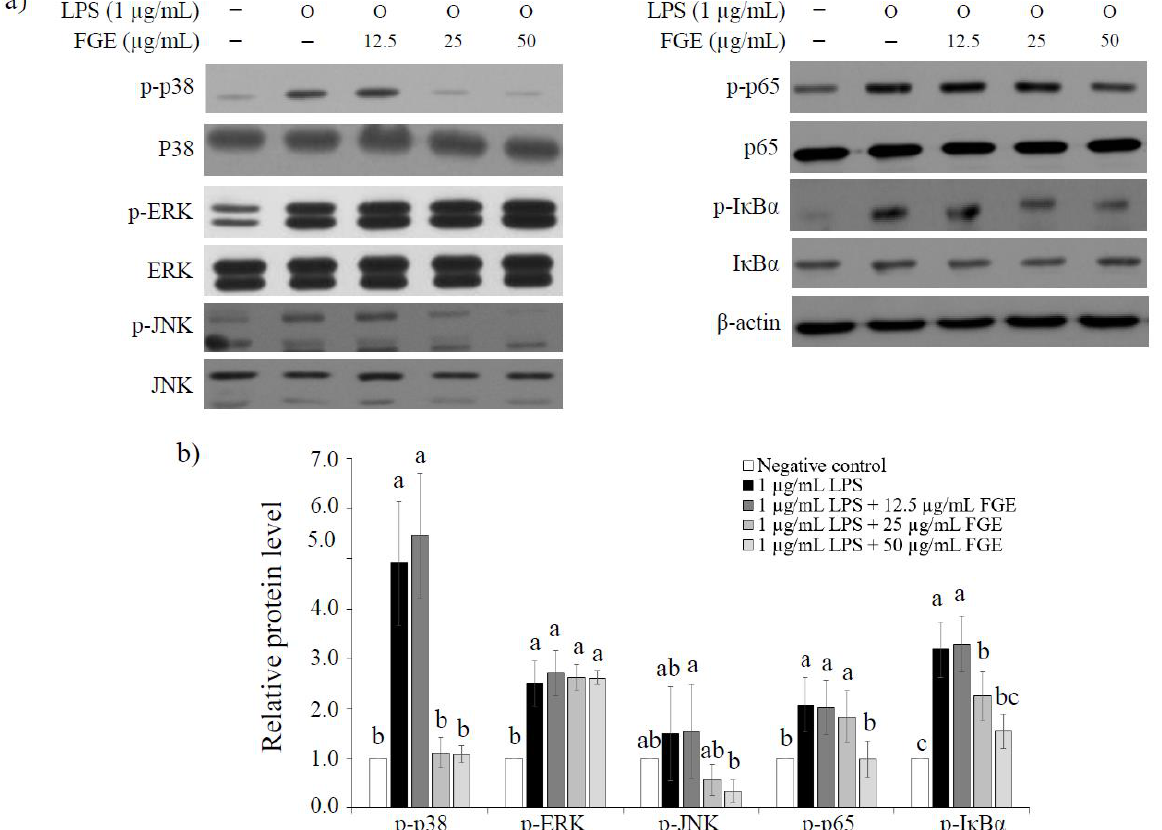
Figure 4. Effect of Filipendula glaberrima Nakai extract on the phosphorylation of MAPKs and NF- κB in LPS -treated RAW 264.7 cells. RAW 264.7 cells were treated with each sample for 30 min, and then stimulated with LPS (1 µg/mL) for a further 30 min. ( a ) Protein was extracted and immunoblotted with the indicated antibodies. β -actin was used as internal loading control. ( b ) Data analysis was performed using ImageJ software by measuring the integrated band densities following background subtraction. The results are expressed as mean ± S.D. of three independent tests in triplicate. Different superscripts mean a significant difference among groups ( p < 0.05) based on a one-way ANOVA and Duncan’s multiple range test. FGE, ethanol extract of Filipendula glaberrima Nakai; MAPK, mitogen- activated protein kinase; NF- κ B, nuclear factor kappa B; LPS, lipopolysaccharide; p-p38, phospho-p38; p-ERK, phospho-ERK; ERK, extracellular signal-regulated kinase; p-JNK, phospho-JNK; JNK,